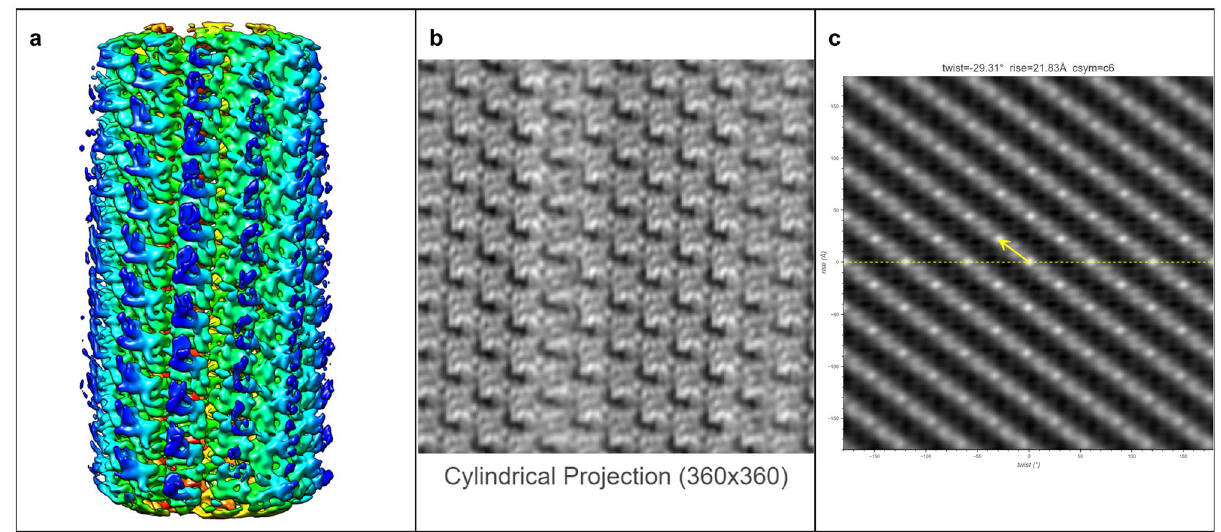
Figure 7. The surface view of the asymmetric reconstruction ( a ), the cylindrical projection ( b ), and the 2D lattice ( c ) with the HI3D outputted helical rise and twist and C-sym of the VipA/VipB dataset (EMPIAR-10029). The surface view was generated with UCSF Chimera 18 .